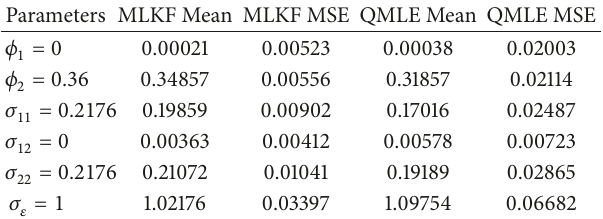
Table 2: Mean and MSE of estimated parameters for Example 1; 𝑛 = 200 .